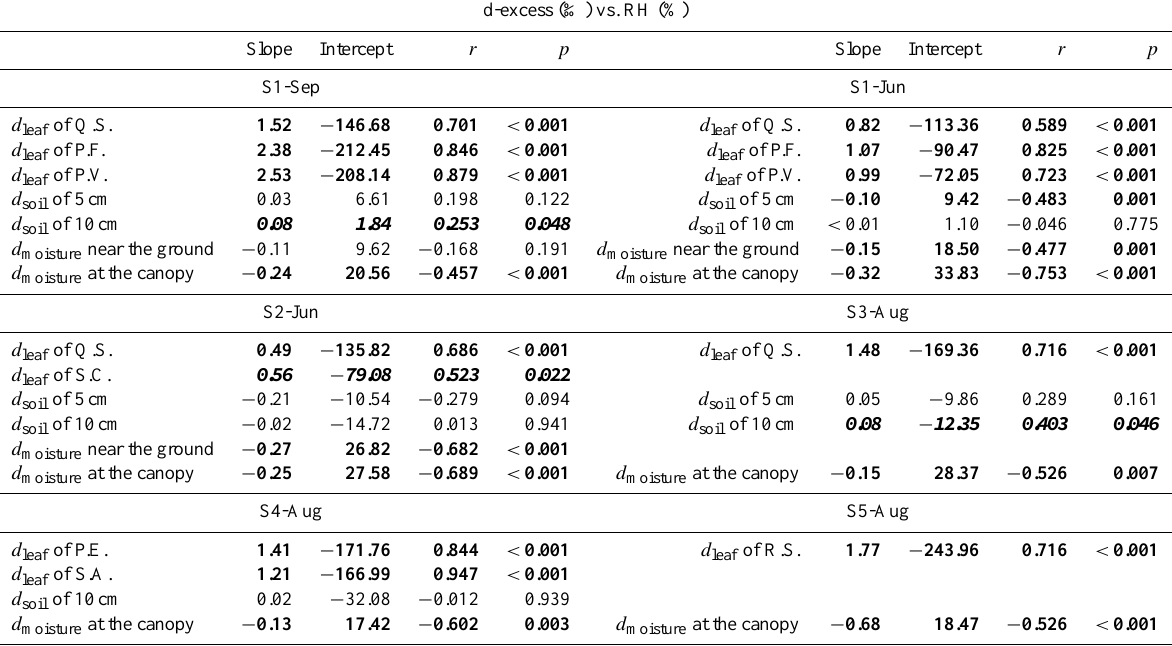
Table 6. Linear least square fits between the d-excess of various water bodies and the relative humidity (RH) (%) at each site. Here, r is the correlation coefficient, and p is the significance level. p < 0.001 indicates statistical significance at the 99.9% significance level, and p < 0.05 indicates statistical significance at the 95% significance level. The location ID and the abbreviations of plant Latin names are the same as in Tables 2 and 3.